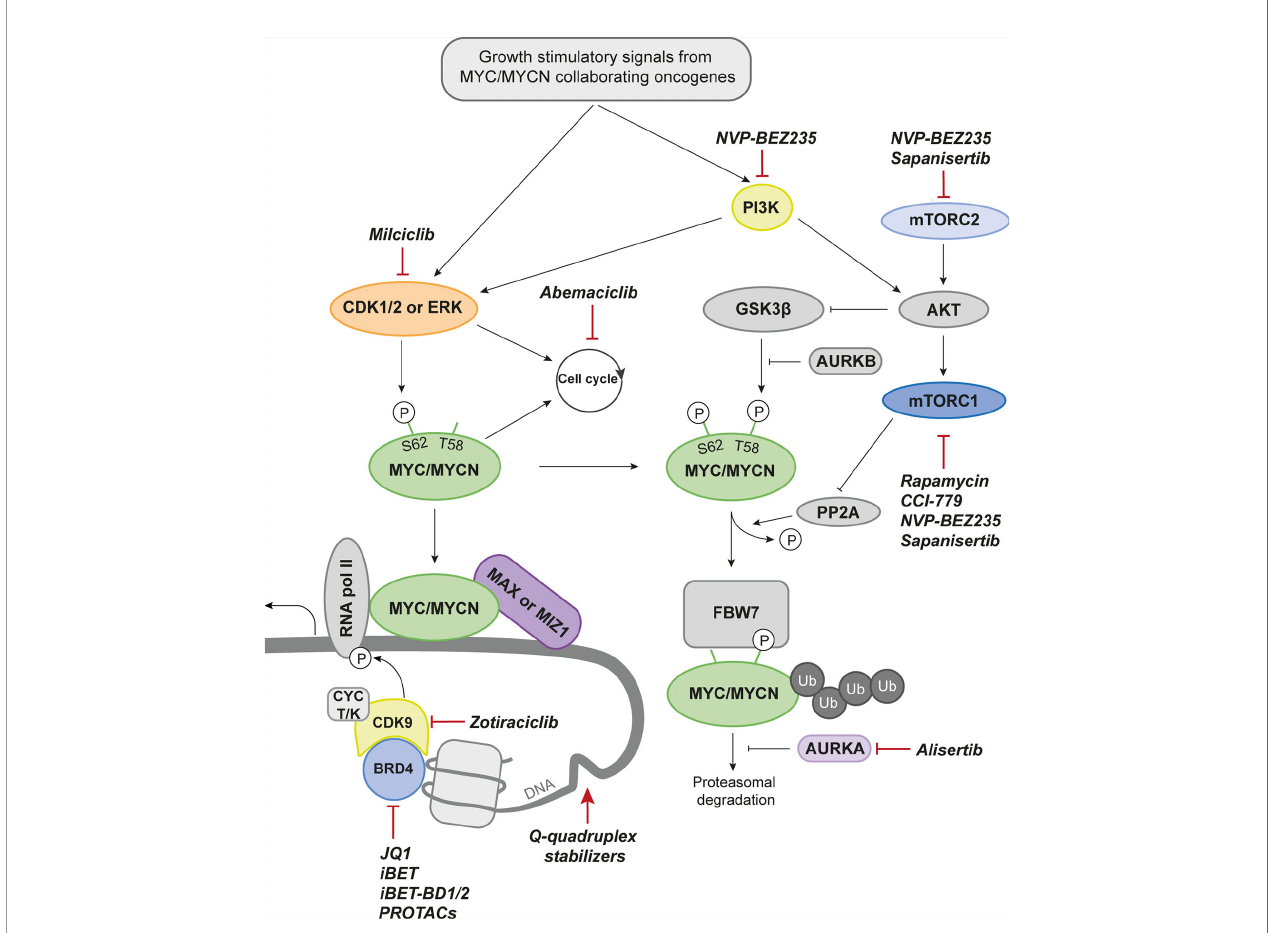
FIGURE 2 | Drug Targets in MYCN Biology. Proteins that can be targeted pharmacologically and discussed in the current review are marked in color. Drugs with preclinical data are denominated with group af fi liation. A selected set of drugs that have reached the clinical stage (either approved or in clinical trials for the indicated target) are named. CDK1/2, Cyclin dependent kinase 1/2; MAX, MYC-associated factor X; MIZ1, MYC-interacting zinc- fi nger protein 1; RNA pol II, RNA polymerase II; BRD4, Bromodomain-containing protein 4; CYC T/K, Cyclin T/K; PROTACs, Proteolysis targeting chimeras; PI3K, Phosphoinositide 3-kinase; AURKB, Aurora kinase B; FBW7, F-box and WD repeat domain-containing 7; Ub, Ubiquitin; AURKA, Aurora kinase A; mTORC2, Mammalian target of rapamycin complex 2; mTORC1, Mammalian target of rapamycin complex 1; AKT, Protein kinase B; PP2A, Protein phosphatase 2; P,